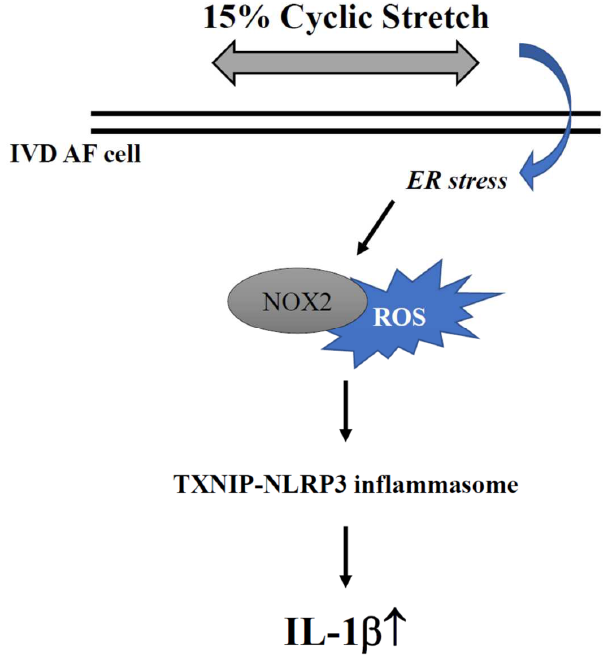
Figure 7. Schematic representation of a possible mechanism affecting 15% HCS-induced ER stress and NOX2 expression and consequent inflammasome activation in human AF cells.